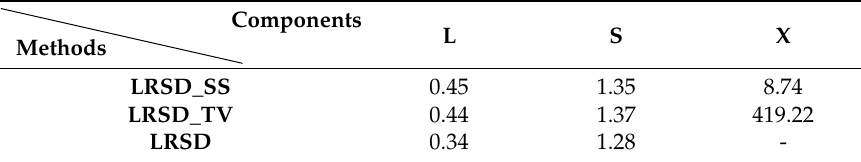
Table 3. Time cost (in seconds) of three LRSD-based change feature extraction